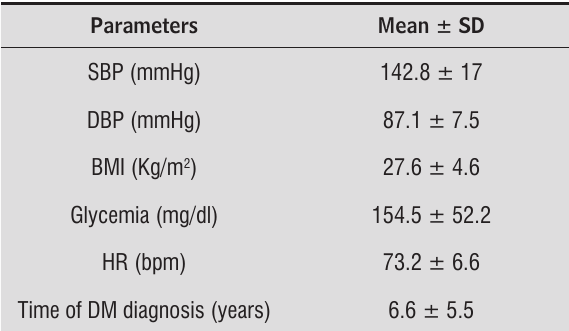
Table 4 - Movement and functional category in relation to the percentage of individuals Movement and Functional